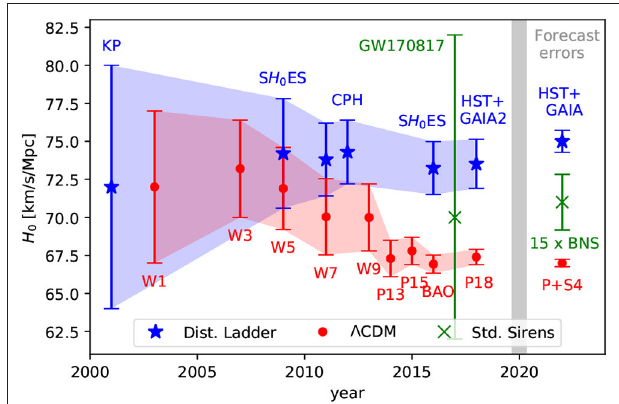
FIGURE 8 | The Hubble tension (adapted from Beaton et al., 2016; Freedman, 2017, including the first standard sirens measurement following GW170817, Abbott et al., 2017b, Planck 2018, Aghanim et al., 2018 and Hubble Space Telescope (HST) with GAIA DR2, Riess et al., 2018). Blue stars correspond to measurements of H 0 in the local universe with calibration based on Cepheids. Red dots refer to derived values of H 0 from the CMB assuming 3 CDM. Green crosses are direct measurements of H 0 with standard sirens. Forecasts are: CMB Stage IV (Abazajian et al., 2016), standard sirens (Nissanke et al., 2013) and distance ladder with full GAIA and HST ( Casertano et al., 2016; Riess et al.,